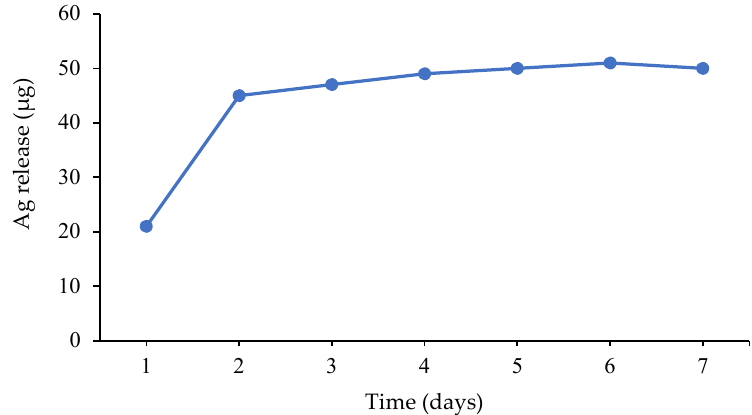
Figure 2. The release of silver from the hybrid hydrogel in vitro.